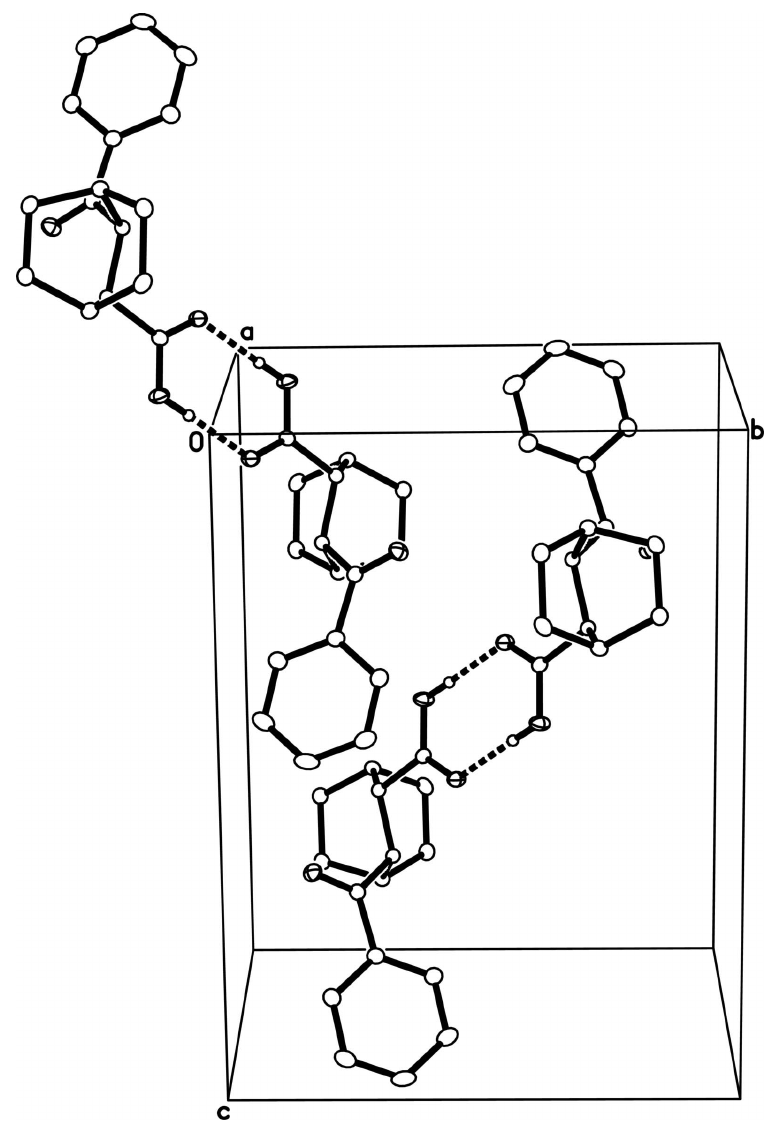
A partial packing diagram, with an extracellular molecule included to show the dimers centered at 1/2,1/2,1/2 and 1/2,0,0. For clarity, all C-bound H atoms are omitted. Displacement ellipsoids are drawn at the 40% probability